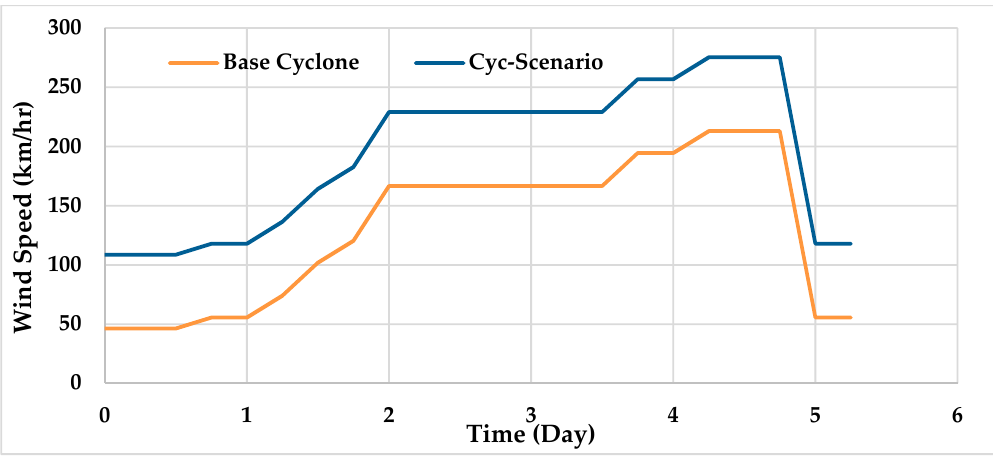
Figure 6. Cyclonic scenarios